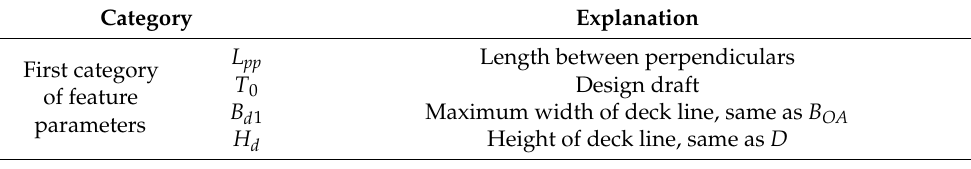
Table 2. Feature parameter codes and